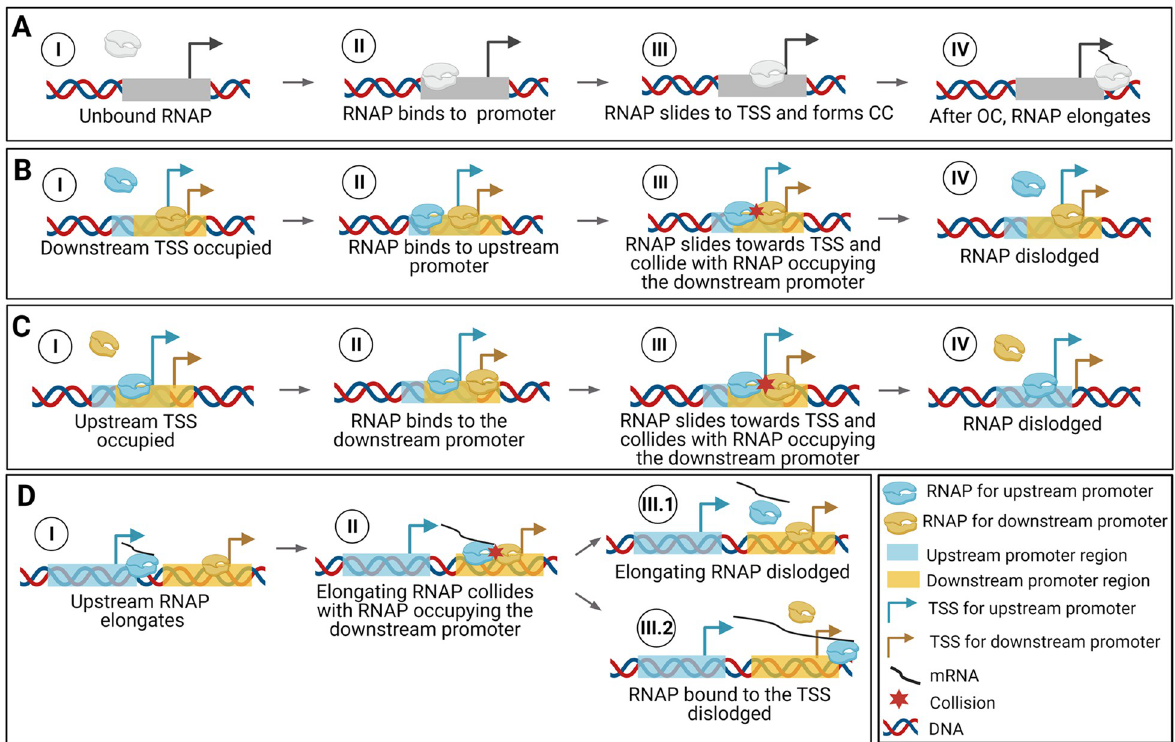
Fig 3. Events leading to transcriptional interference between tandem promoters. ( A ) Sequence of events in transcription in isolated promoters. A similar set of events occurs in tandem promoters, if only one RNAP interacts with them at any given time. ( B / C ) Interference due to the occlusion of the downstream / upstream promoter by a bound RNAP, which will impede the incoming RNAP from binding to the TSS. ( D ) Interference of the activity of the RNAP incoming from the upstream promoter by the RNAP occupying the downstream promoter. One of these RNAPs will be dislodged by the collision. Created with